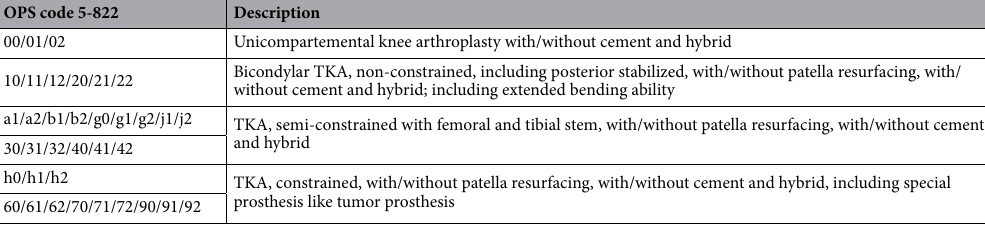
Table 1. OPS codes for the procedures carried out and